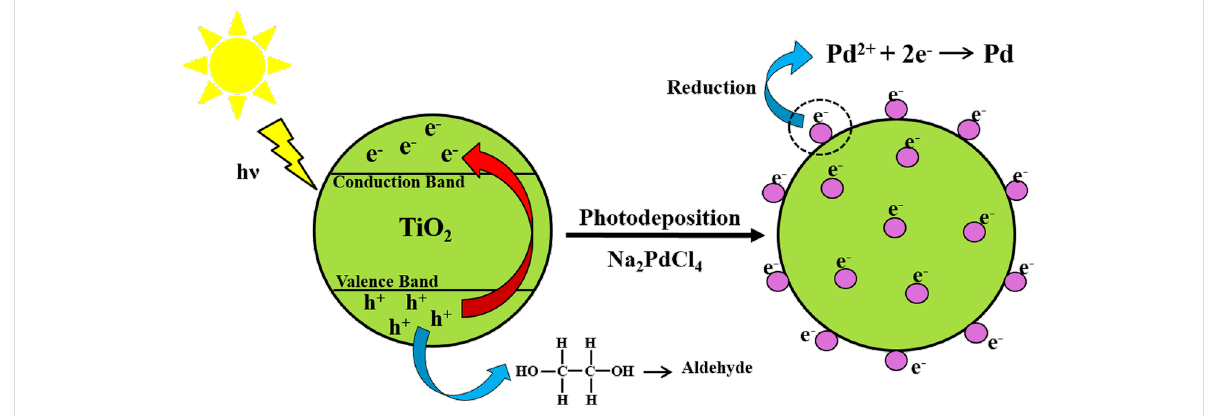
Figure 1: Schematic diagram for the synthesis of Pd/TiO 2 trough solar-assisted photodeposition.